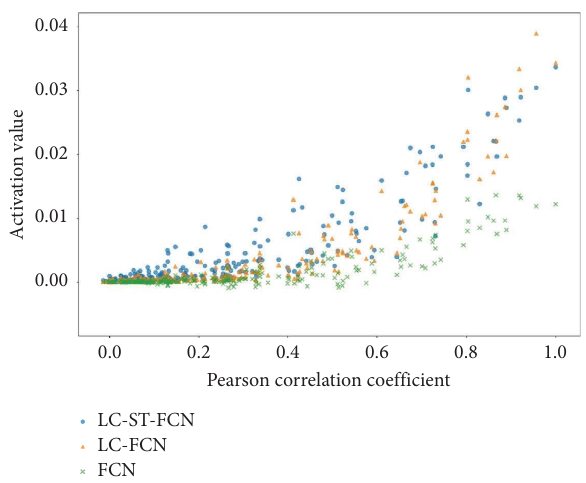
Figure 9: Te activation values with and without locally connected convolutional